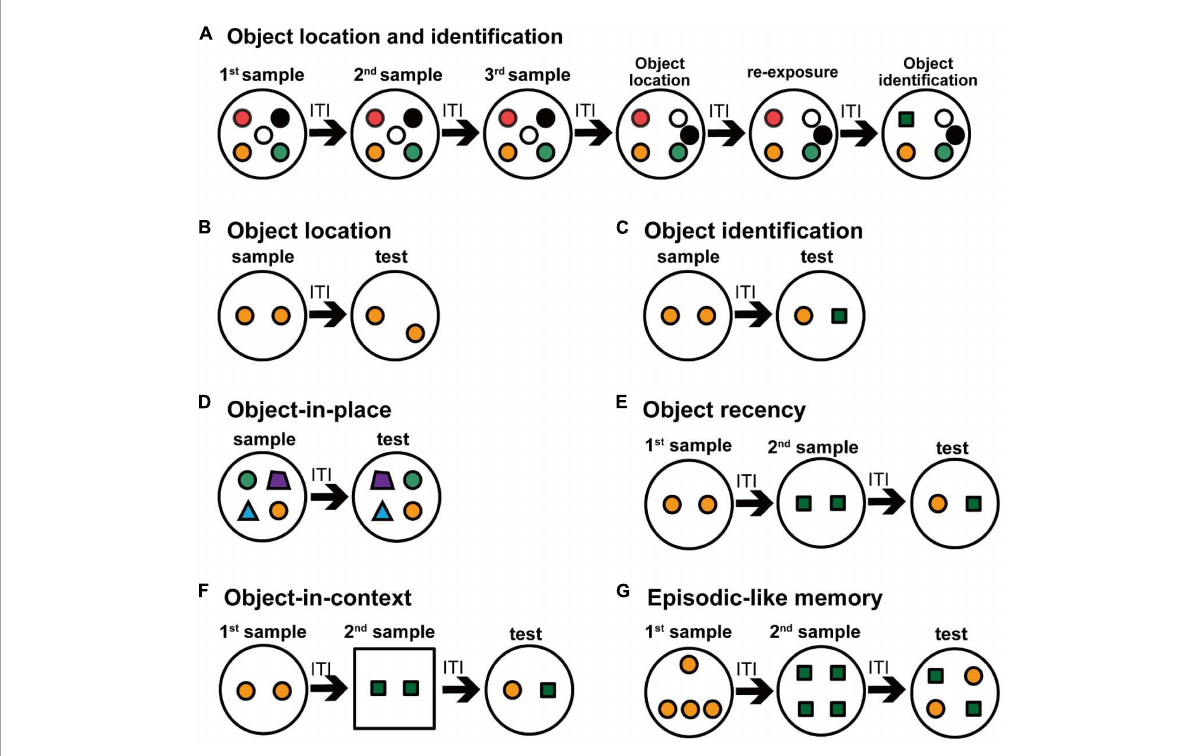
FIGURE2 Schematic drawing of various object recognition tasks in rodents. Small colored circles and polygons indicate objects in an open field. Experimental protocols for evaluating the object recognition memory are shown. (A) The multiple-trial task evaluates the object recognition memory for the location and identification of the objects. In this task, successive six exposures are conducted with an ITI within 1 day. After three trials of sample exposure, two objects were relocated and an object location test is conducted. After re-exposure to the same arrangement objects in the object location test, a familiar object is replaced by a novel object in the object identification test. (B–G) One-trial tasks evaluate the object recognition memory, in which a sample trial and a test trial are conducted with an ITI on the same day, and some changes in the experimental conditions as for the objects are made in the test trial. In the object location task (B) , one of two objects is relocated in the test trial. In the object identification task (C) , one of two objects is replaced with another object in the test trial. In the object-in-place task (D) , two of four objects are relocated in the test trial. In the object recency task (E) , two objects in the first sample are exchanged by two other objects in the second sample, and then different objects in two samples are presented in the test trial. In the object-in-context task (F) , a set of objects in a context in the first sample are replaced with another set of objects in a different context in the second sample, and then different objects in two samples in the first context are presented in the test trial. In the episodic-like memory task (G) , four objects in the first samples are exchanged by four other objects in the second sample, and then the objects consisted of two objects from each sample are presented in the test